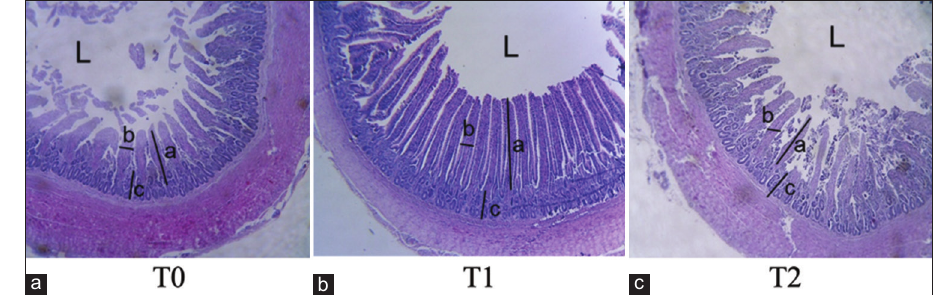
Figure-1: The resulting histomorphology of the duodenum of the small intestine of the hybrid ducks after treatments of alfalfa supplementation. a, villus height; b, villus width; c, crypt depth; and L, small intestinal lumen at 4× microscopic magnification. T0=commercial feed without fresh alfalfa supplementation, T1=commercial feed+supplementation of 3% fresh alfalfa, T2=commercial feed+supplementation of 6% fresh alfalfa. Table-4: Effect of alfalfa supplementation on nutrient digestibility of hybrid duck.